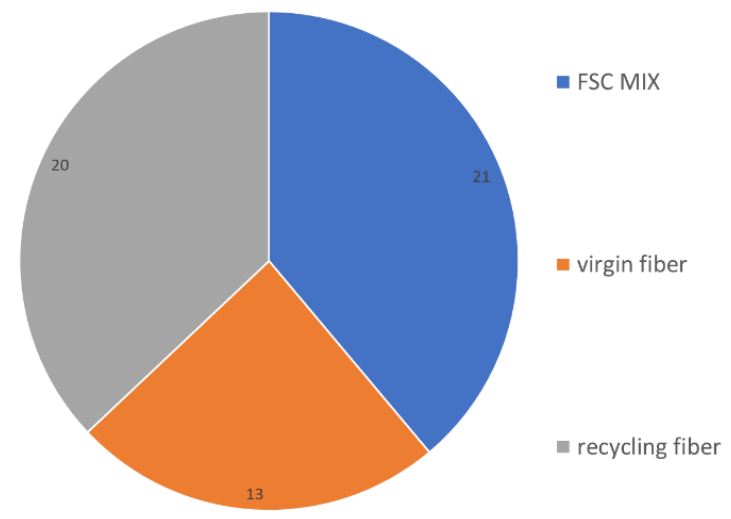
Figure 8. Used fibre material for fibre-based packagings; numbers: number of samples, n = 54.